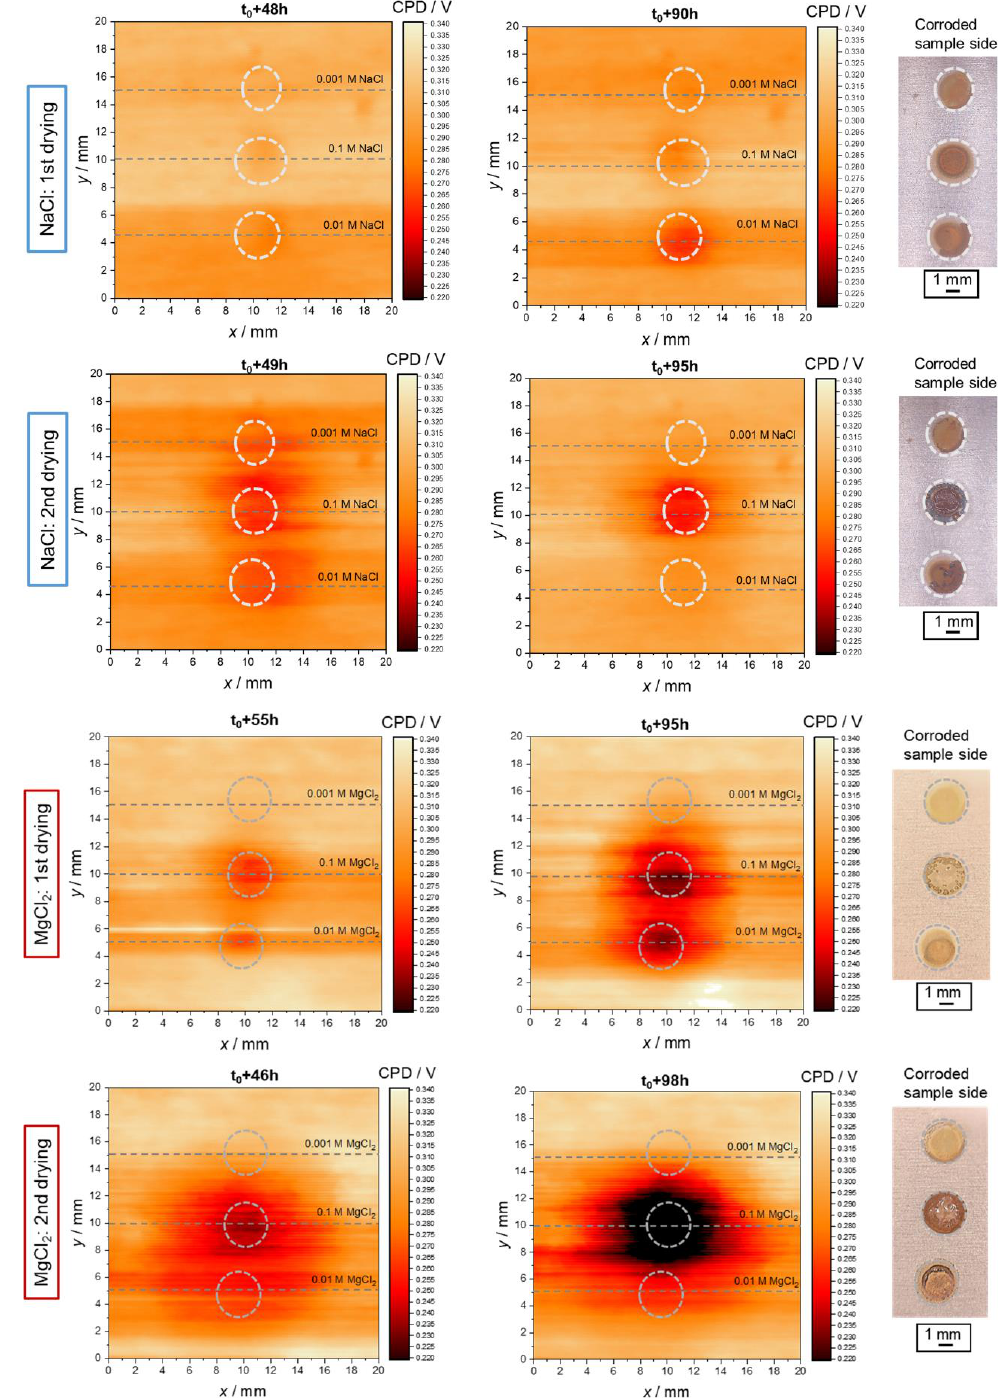
Figure 1. CPD surface maps determined with SKP on the non-corroded sample side of CP1000 approx. 2 and 4 days after application of salt solution droplets and after rewetting, respectively. Positions of dried/rewetted droplets are indicated on the SKP scans, as well as on the optical images of the corroded side of the samples (right). Time t 0 represents the start of droplet drying.